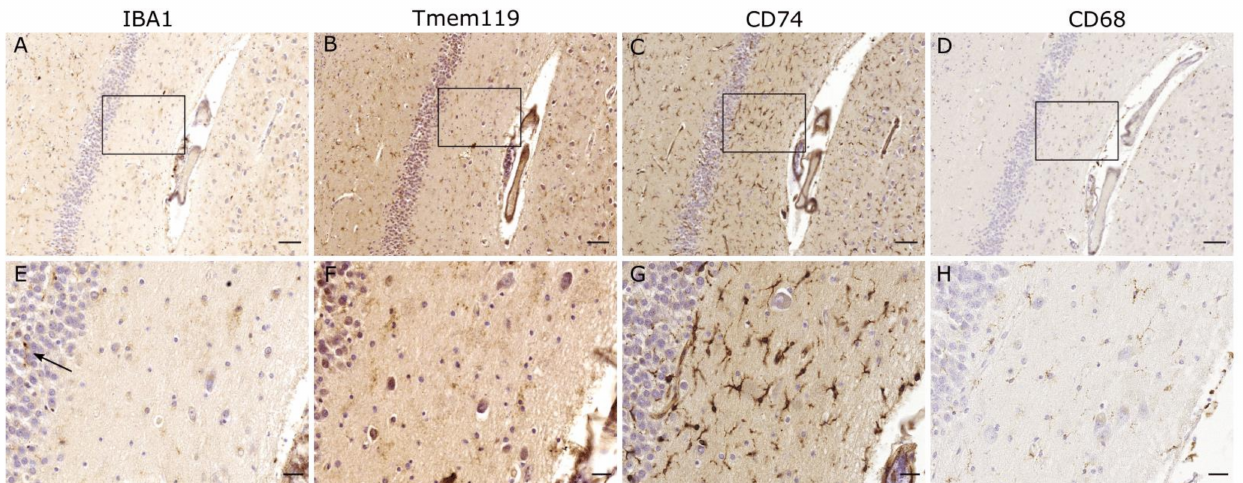
Figure 2. IBA1-negative microglia. Regions seemingly devoid of microglia in the IBA1 staining, exhibit positive staining for several other microglial markers such as TMEM119, CD74 and CD68. Occurrence of IBA1-positive microglia at the margin ( ↑ ) suggests only localized changes. Scale bars: ( A – D ): 100 µ m, ( E – H ): 25 µ